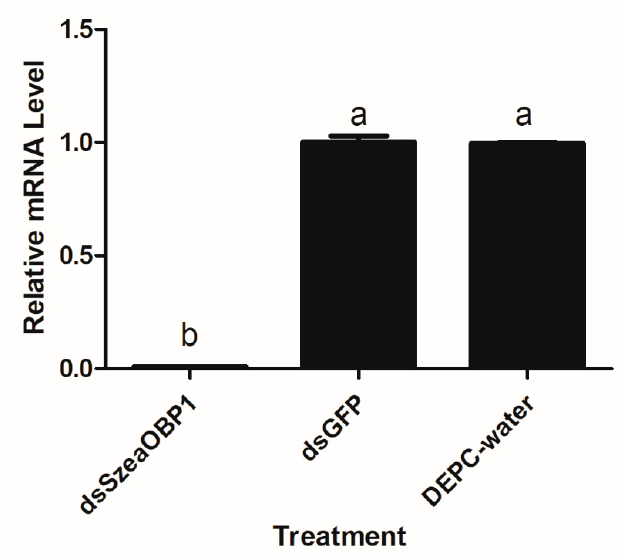
Figure 9. Effect of RNAi treatment on the transcript levels of SzeaOBP1 in adults. DEPC-water and GFP were compared as controls.